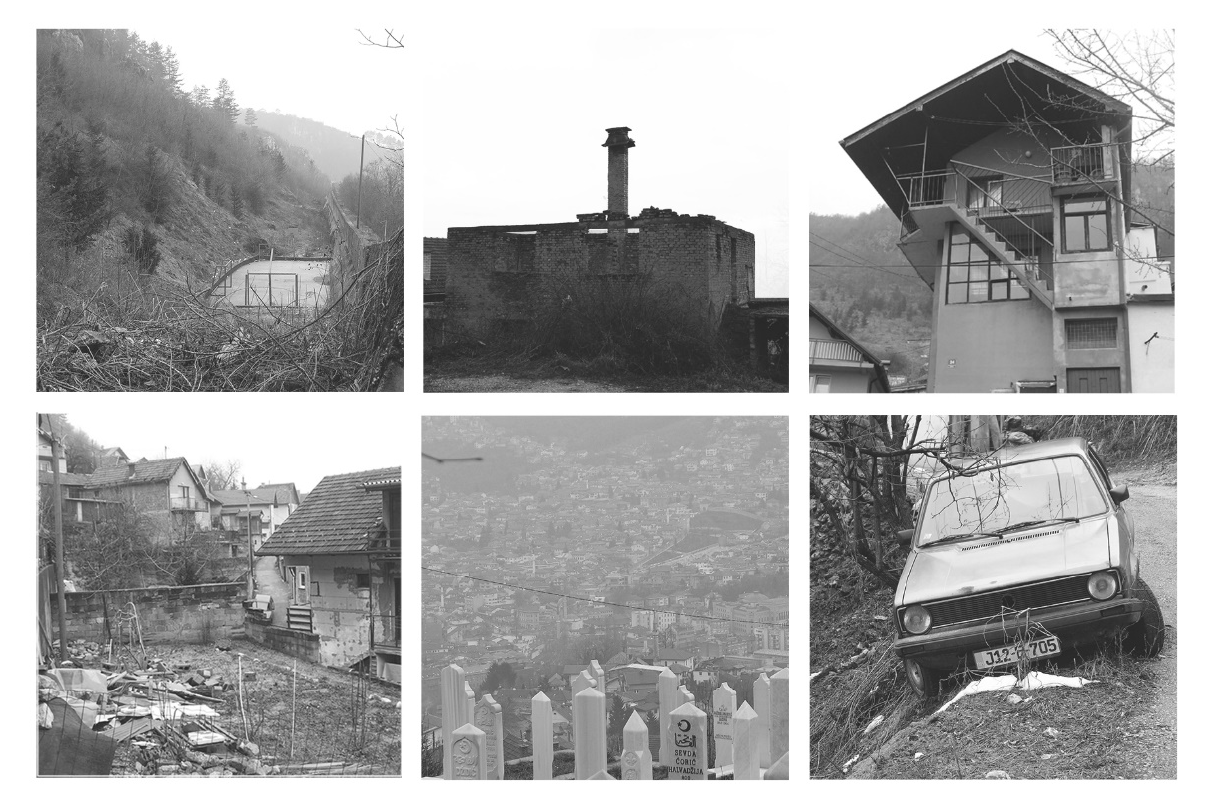
Figure 10: The mahala of Širokača. Examples of analysed elements within the built fabric and the natural